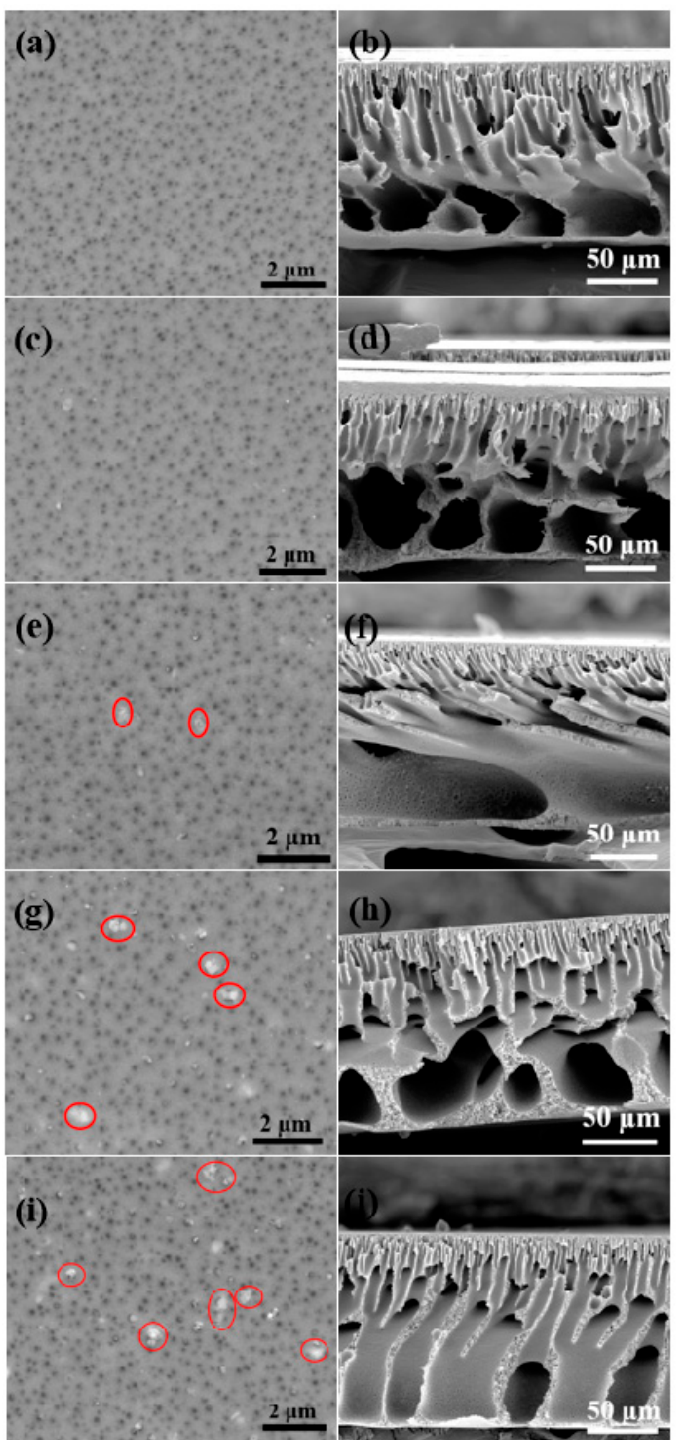
Figure 3. Surface and cross-sectional images of membrane supports: ( a,b ) S-0, ( c,d ) S-0.05, ( e,f ) S- 0.1, ( g,h ) S-0.15, and ( i,j ) S-0.2. ( g , h ) S-0.15, and ( i , j )